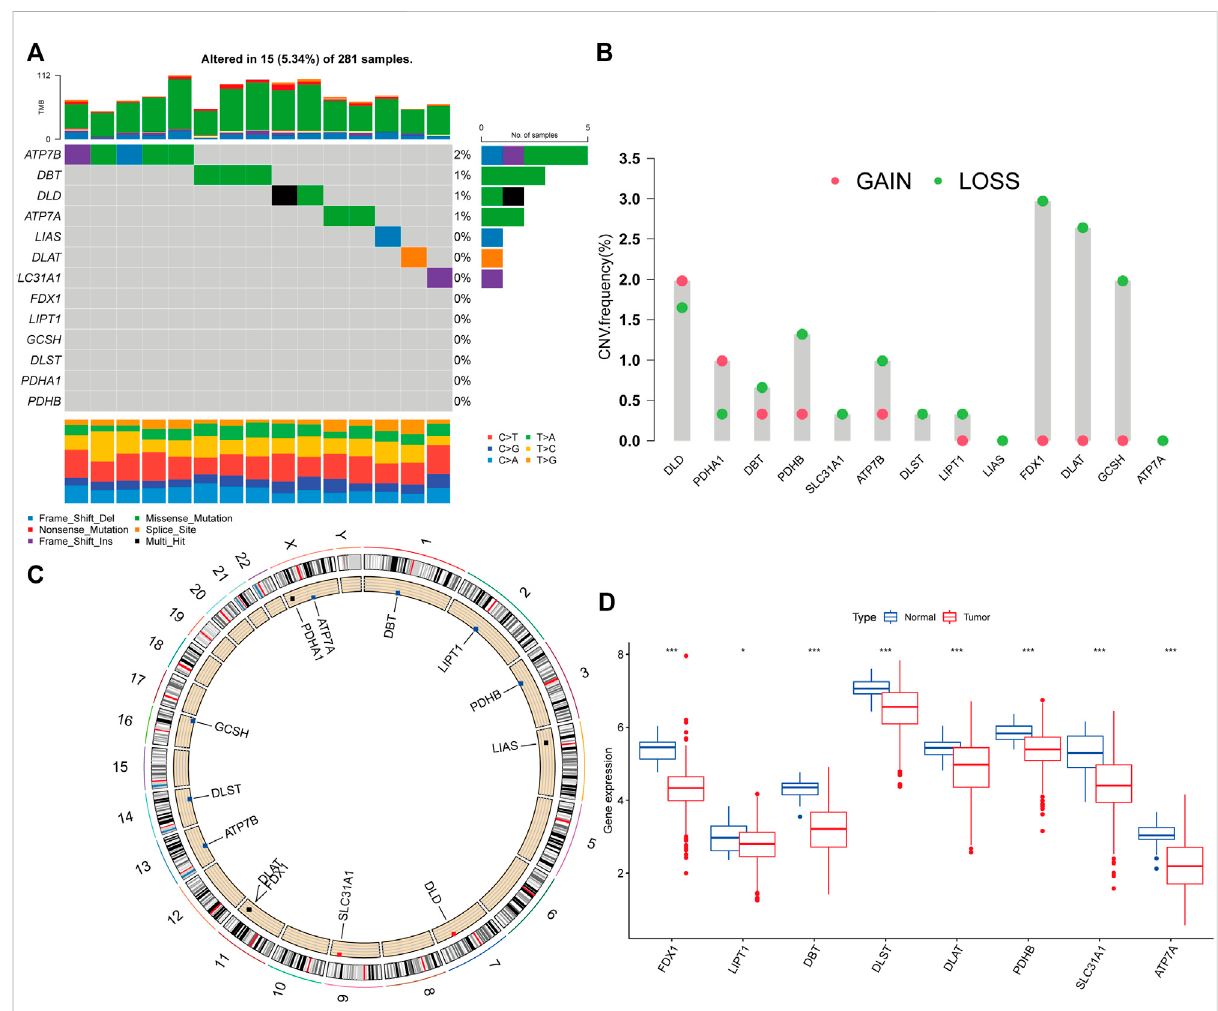
FIGURE 1 Cuproptosis-related genes (CRGs) genetic variation landscape in papillary renal cell carcinoma (PRCC). (A) The frequency of CRGs mutations in 281 patients with PRCC. On the right, the number indicated the mutation frequency of the CRGs. (B) The CRGs ’ copy number variation (CNV) frequency. The column indicated the frequency of variation. Red: gain frequency. Green: loss frequency. (C) The chromosomal location of theCRGs with a CNV. (D) Analysis of the mRNA expression of CRGs in normal and PRCC tissues. Blue: normal renal tissue. Red: tumor tissue. (* p < 0.05; *** p <